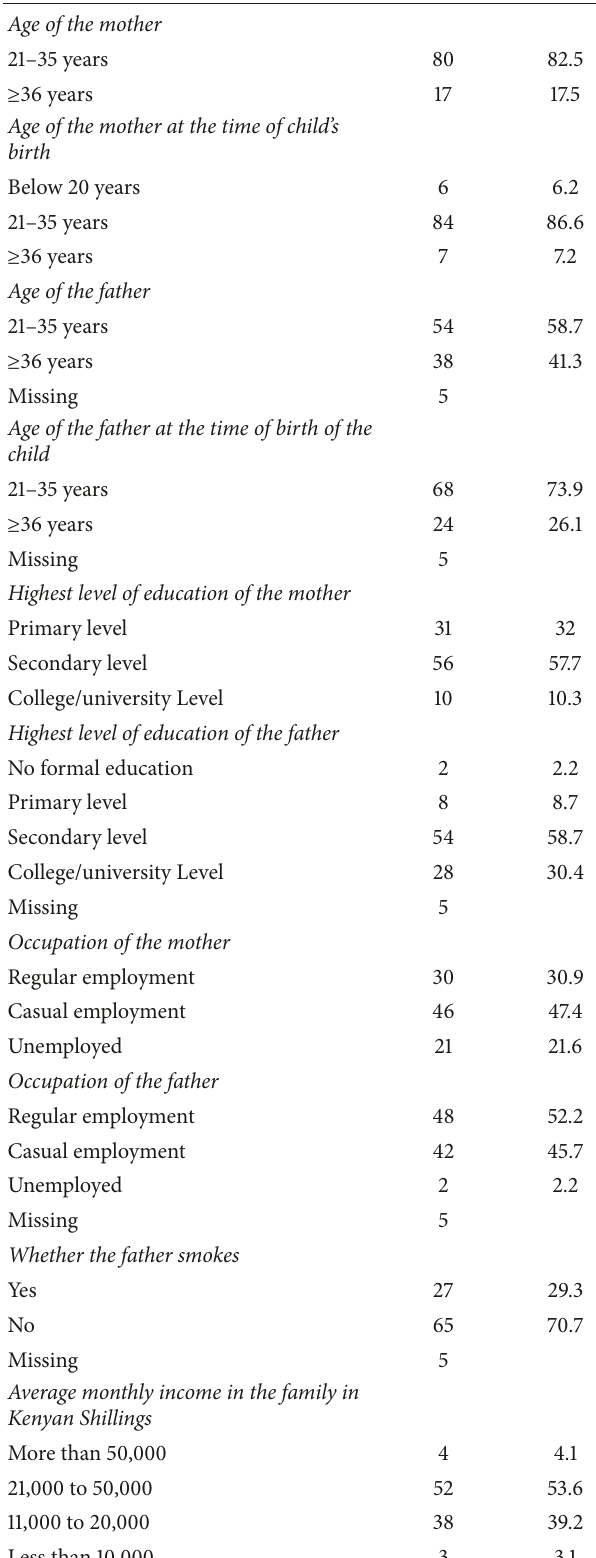
Table 1: Distribution sociodemographic characteristics among the children.